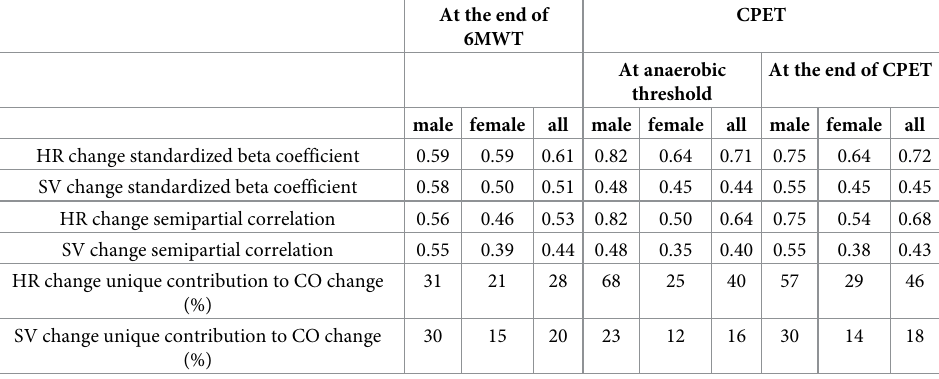
Table 4. Contributions of unique changes in HR and SV to changes in CO (multiple linear regression analyses using change in CO as an outcome variable).